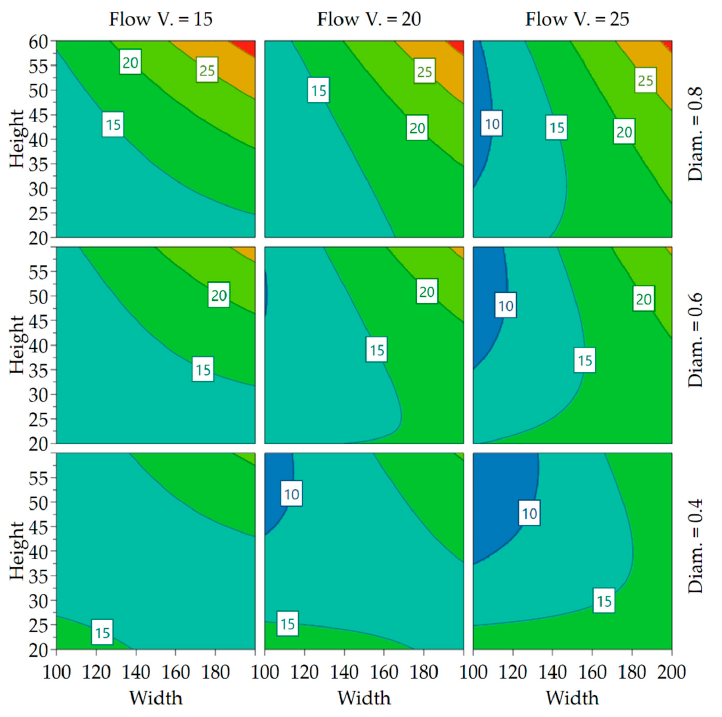
Figure 10. 4D contour plot of fiber orientation labels showing the standard deviation of fiber alignment of the levels, Width and Height in %, Flow Velocity in mm/s and Diameter in